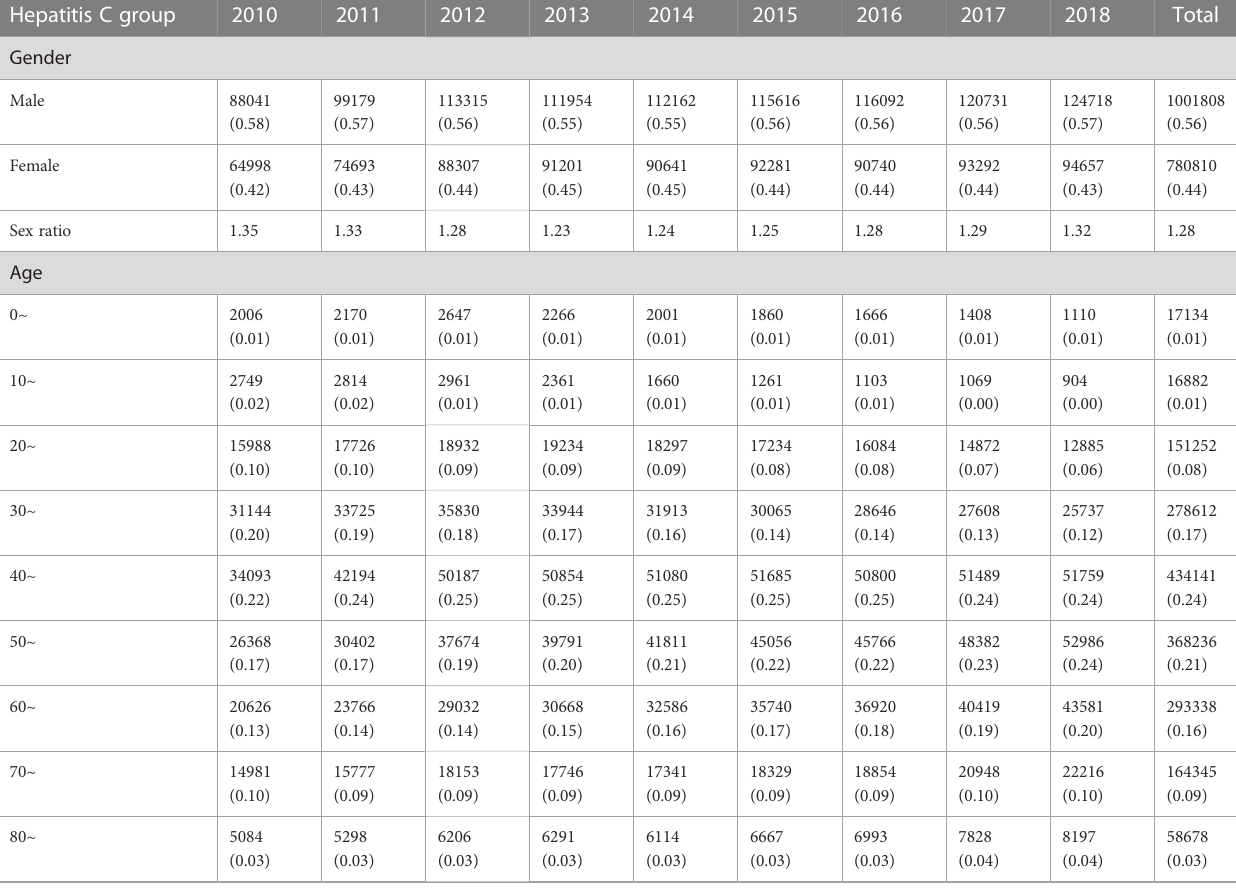
TABLE 2 Demographic characteristics of hepatitis C cases in mainland China, 2010 –